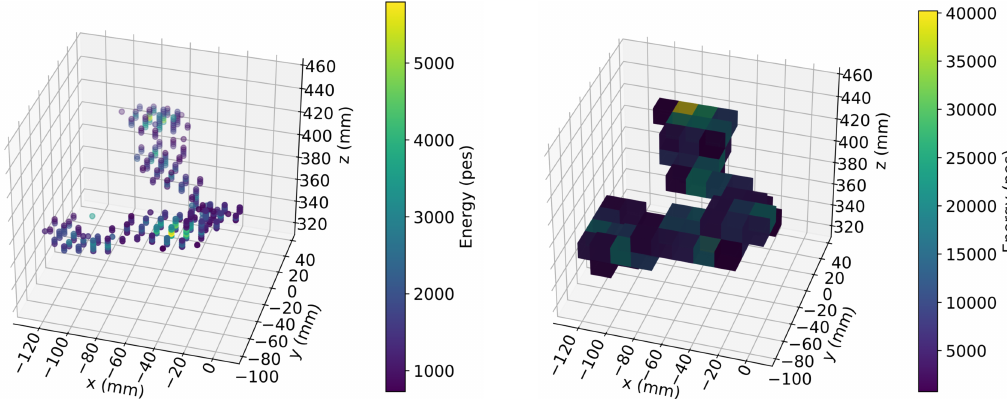
Figure 2 . An example for a reconstructed event in NEXT-White. Left: SiPM hits, with color representing detected photons; right: same event voxelized in 15 × 15 × 15 mm 3 bins (from